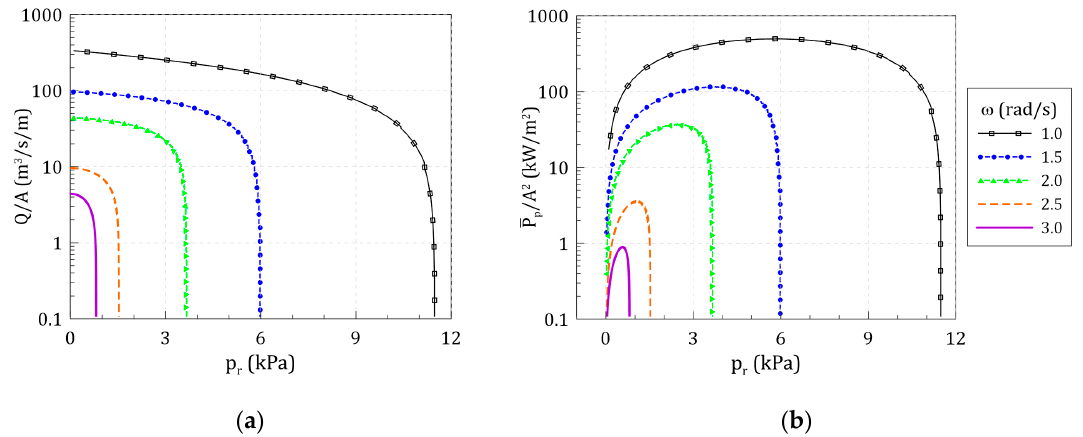
Figure 10. Transfer function of the pneumatic responses of the OWC chamber depending on the radiation pressure: ( a )